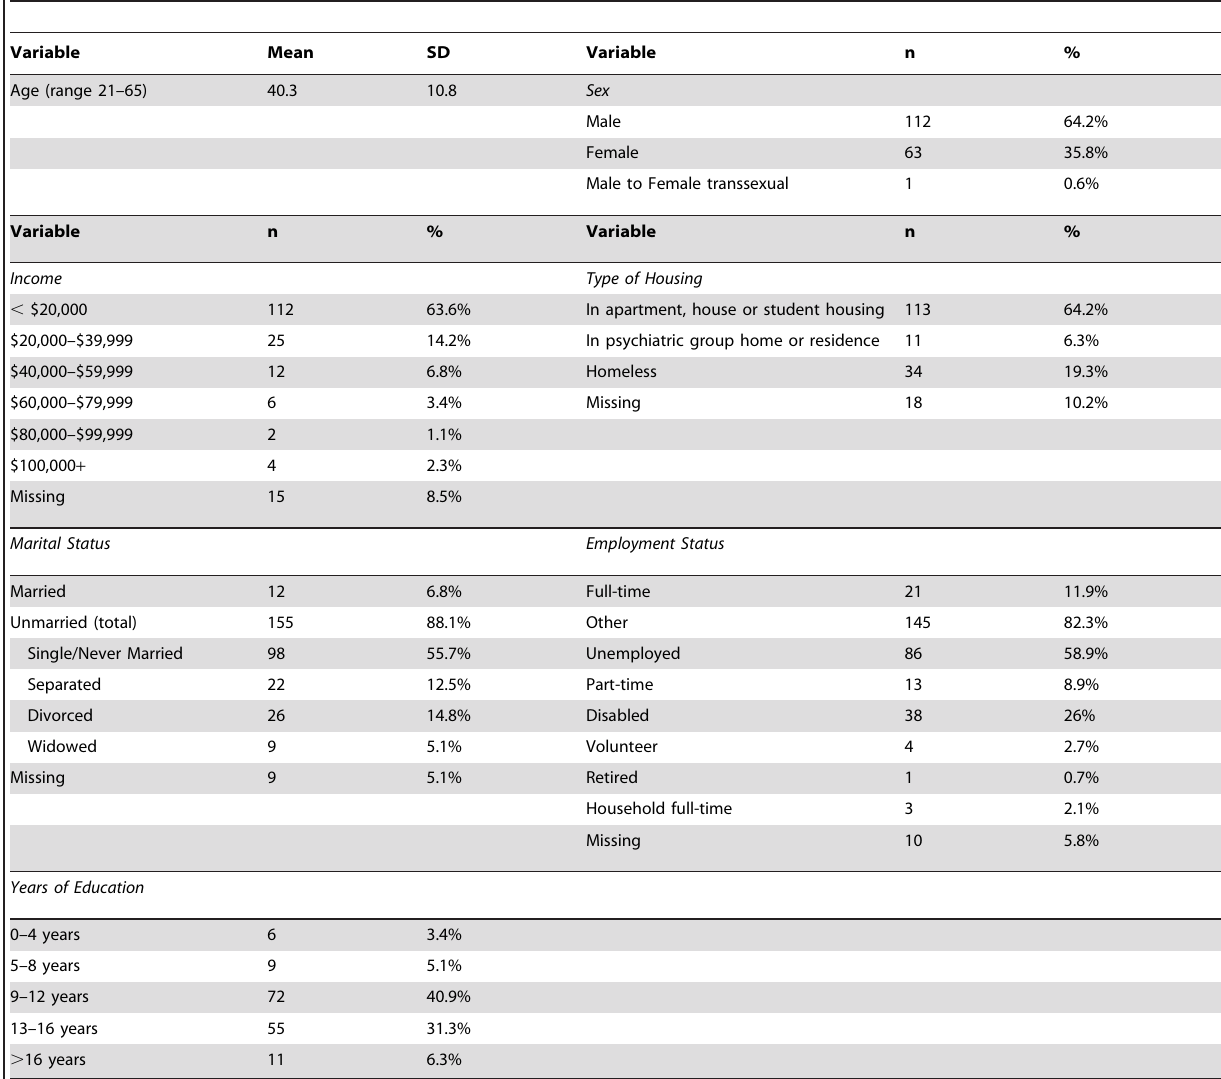
Table 1. Demographic Characteristics of